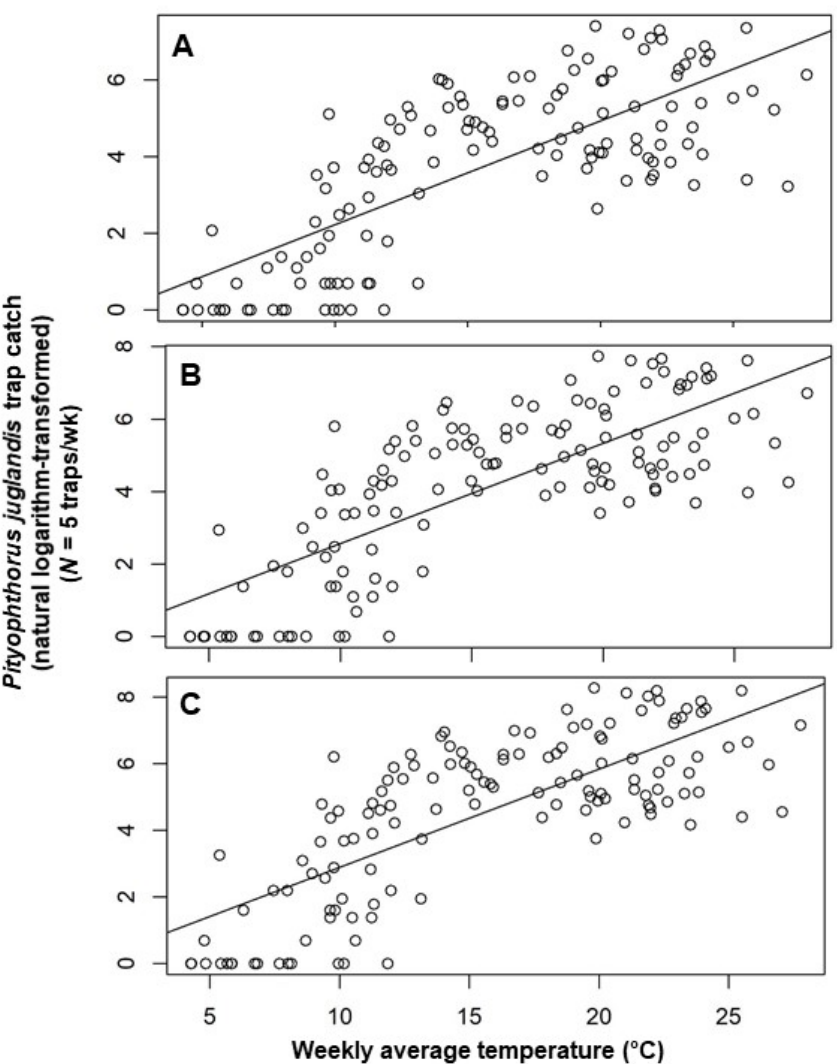
Figure 2. Scatter plot of weekly catches of Pityophthorus juglandis per trap (natural logarithm-transformed) against weekly average temperature ( ◦ C). ( A ) Male; ( B ) Female; and ( C ) Total. The straight line is the linear regression fitted by ordinary least square. Pityophthorus juglandis was collected weekly from 29 August, 2011 to 2 June, 2014 in a native riparian forest stand of northern California black walnut, Juglans hindsii ; Fremont’s cottonwood, Populus fremontii ; and valley oak, Quercus lobata , located along the north fork of Putah Creek in Davis in Yolo Co., California, USA.